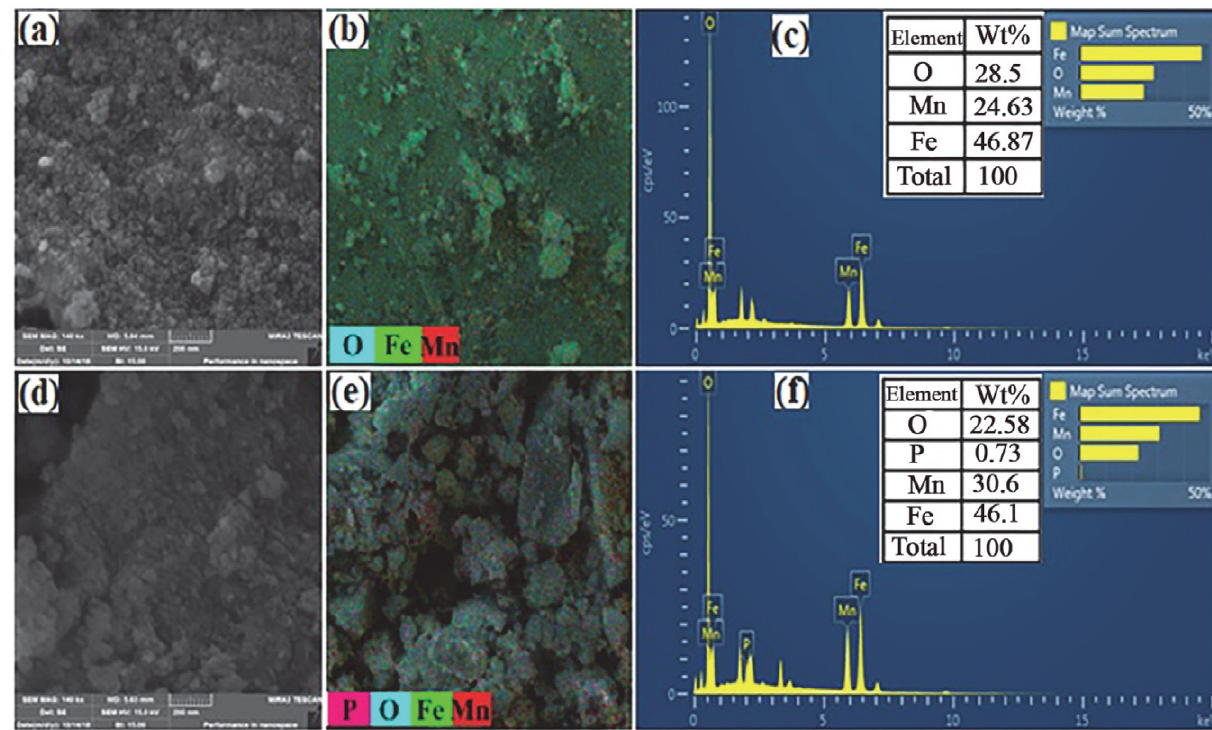
Figure 1. SEM, Mapping, and EDAX analysis for MnFe 2 O 4 nanoparticles before sorption (a-c) and after sorption of P ions (d-f)